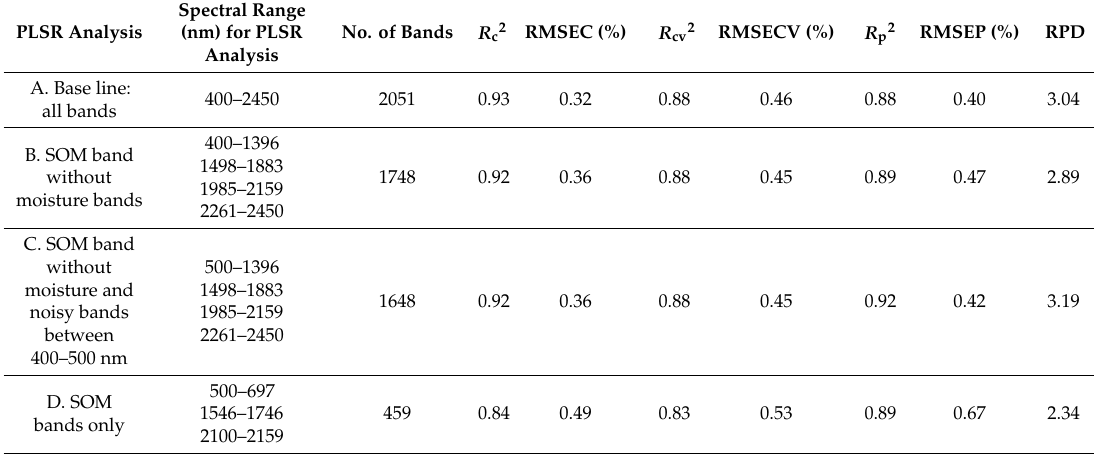
Table 4. Shows the goodness of the SOM content predictions through the partial least square regression (PLSR) analysis under four di ff erent sets of spectral inputs for building the PLSR